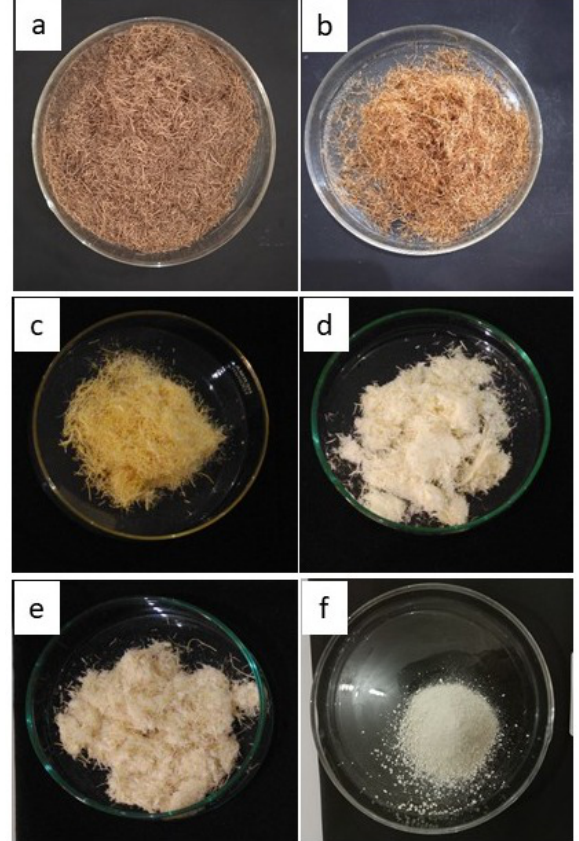
Fig. 1. Image of the untreated and the pretreated OPEFBs, (a) Untreated OPEFB; (b) Pretreated OPEFB using NaOH 10%; (c) Pretreated OPEFB using NaOH 10% and H 2 O 2 1.5%; (d) Pretreated OPEFB using NaOH 10% and H 2 O 2 24%; (e) Pretreated OPEFB using NaOH 10% and NaClO 2 1.4%; (f) Pretreated OPEFB using NaOH 10% and NaClO 2